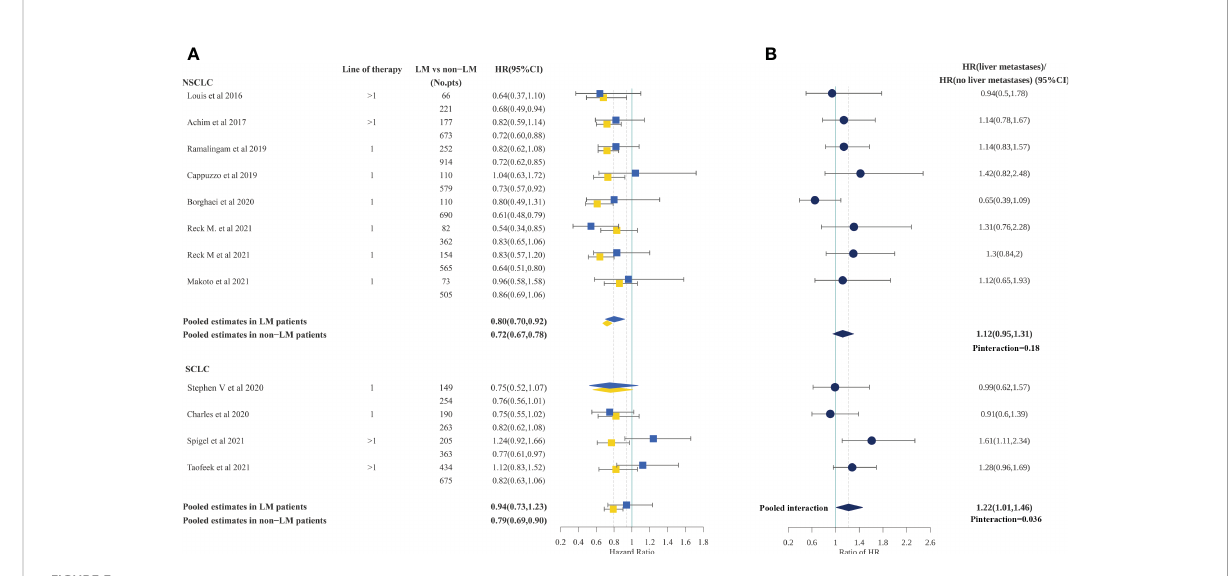
FIGURE 3 Forest plot of hazard ratios for OS according to liver metastases in non-small cell lung cancer and small cell lung cancer patients. (A) , Hazard Ratios for OS when comparing immunotherapy to control treatment. (B) , The interaction between OS bene fi t of immunotherapy and liver